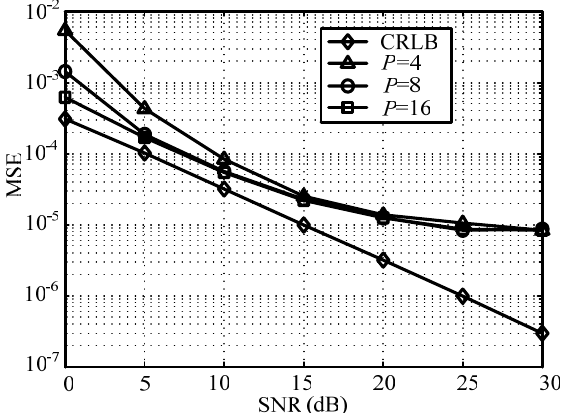
Fig. 2. Performance of quasi-optimal multi-parameter optimization method